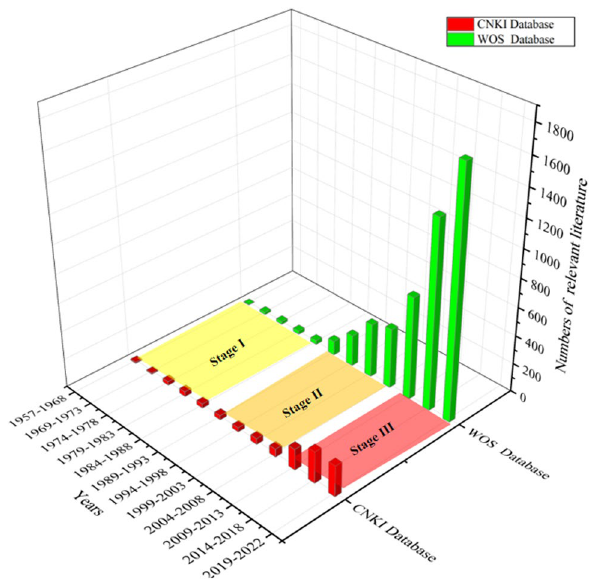
Fig. 2 Trends in the number of relevant literature published from 1957 to